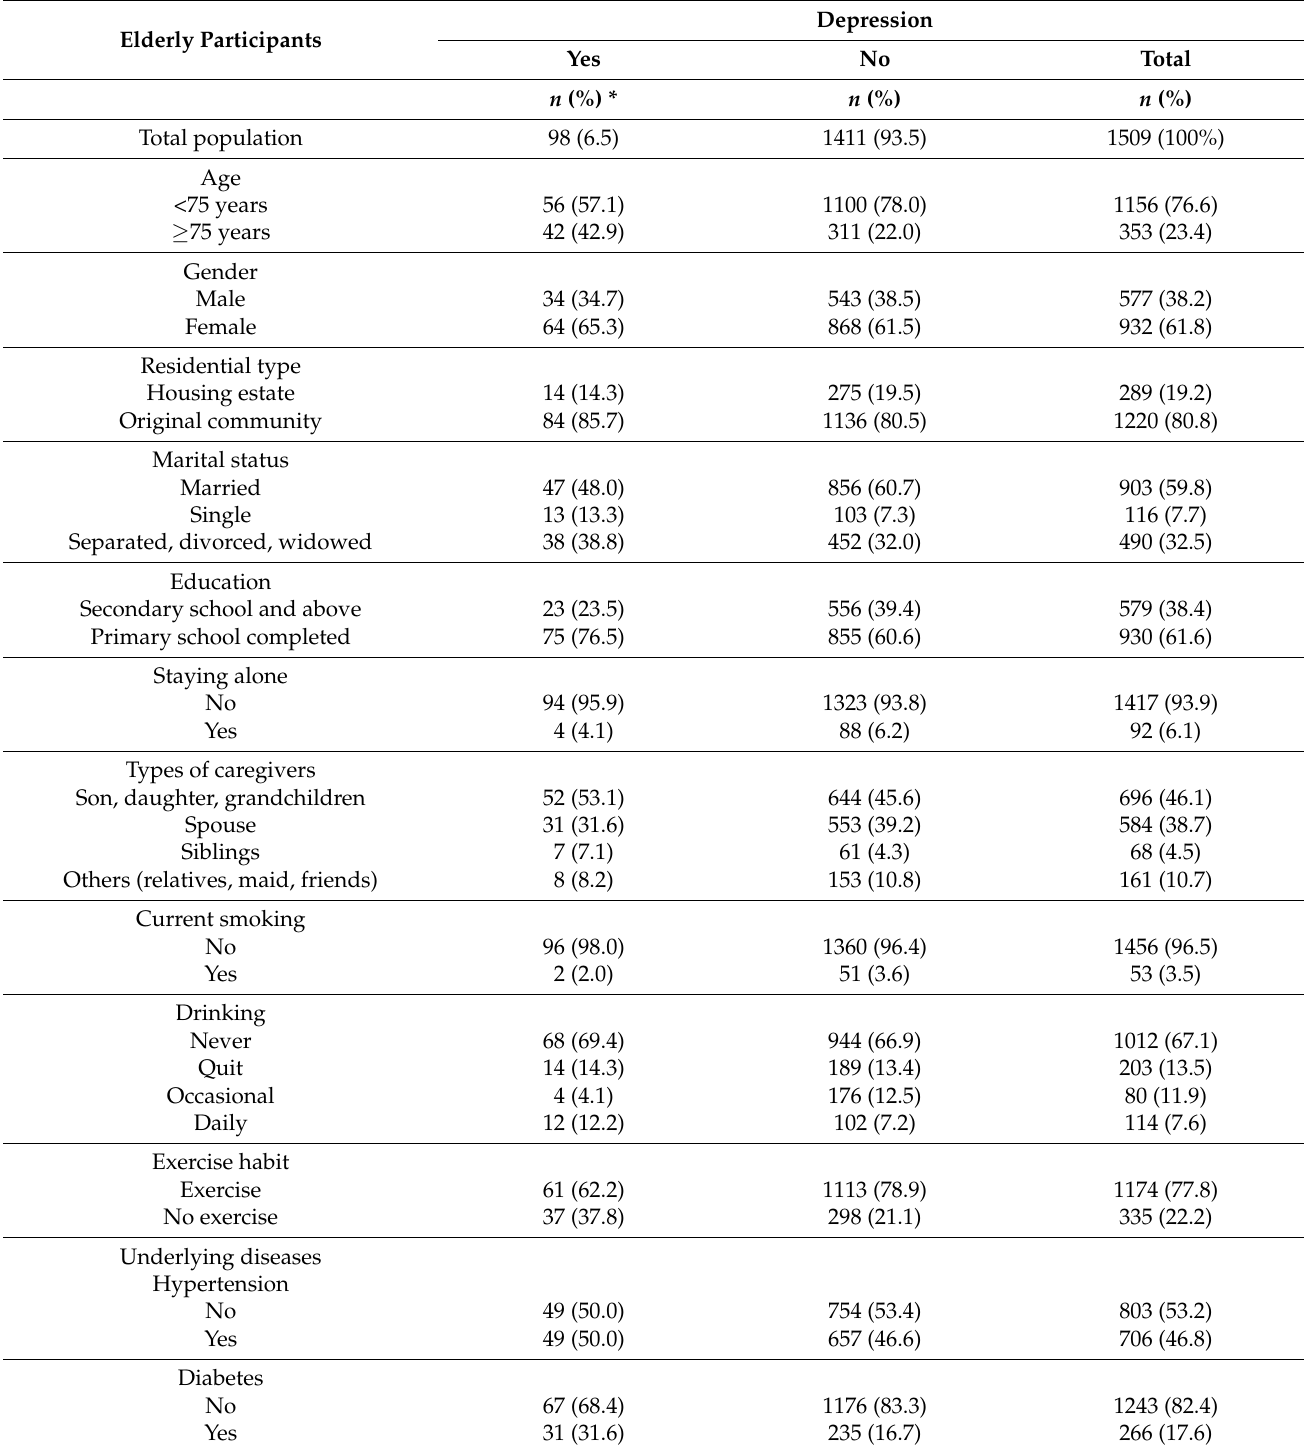
Table 1. Sociodemographic characteristics of study participants, Maehia, Chiang Mai, Thailand ( n =